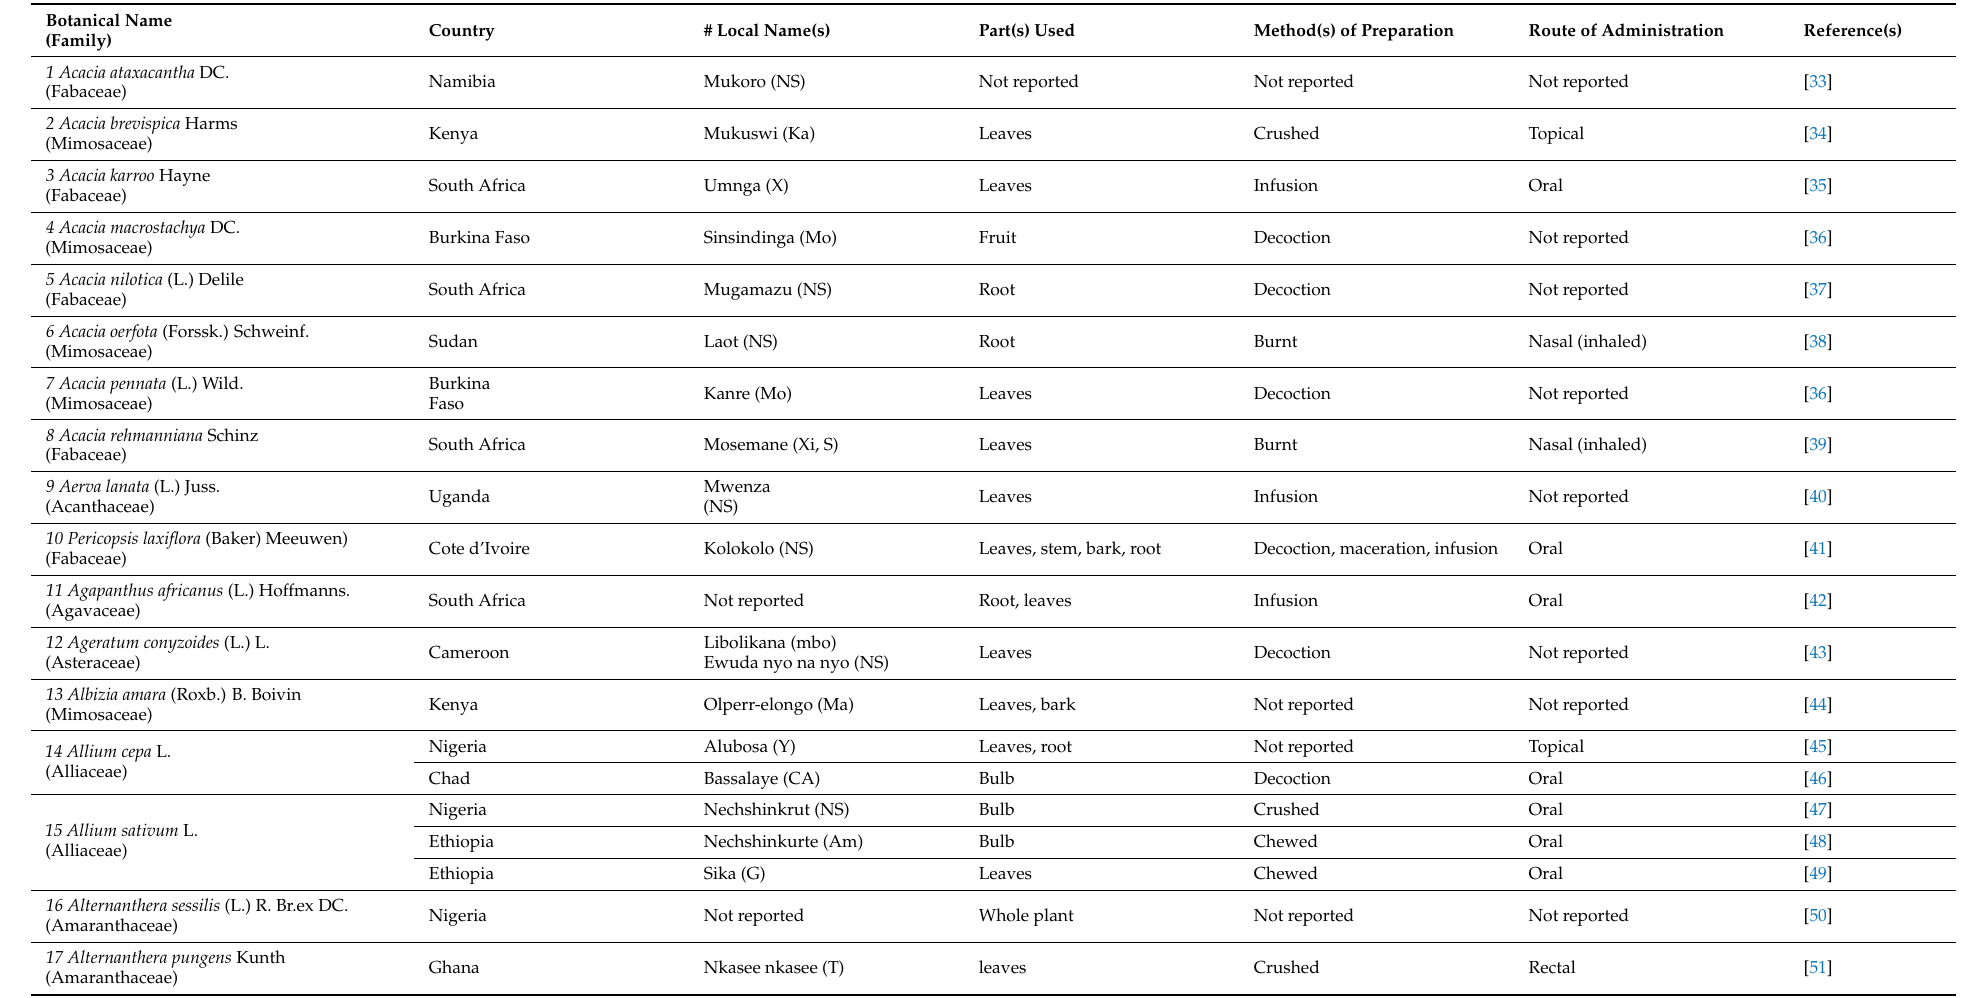
Table 2. Overview of the medicinal plants used in the management of headache in